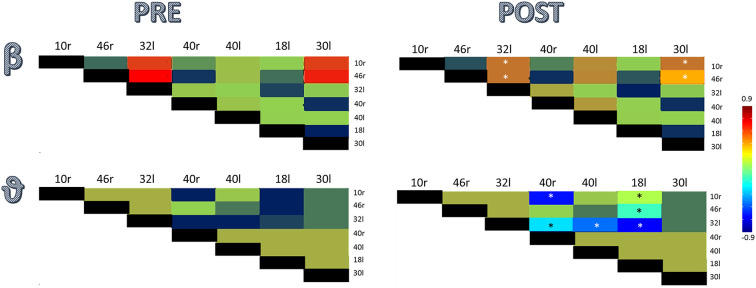
Component-wise correlation coefficients (among the significant ICs outlined in Figure 1), color-coded by whether ICs’ correlation coefficient is ranging from −0.9 to 0.9, before and after rTMS treatment (*means a statistically significant change, p < 0.001).